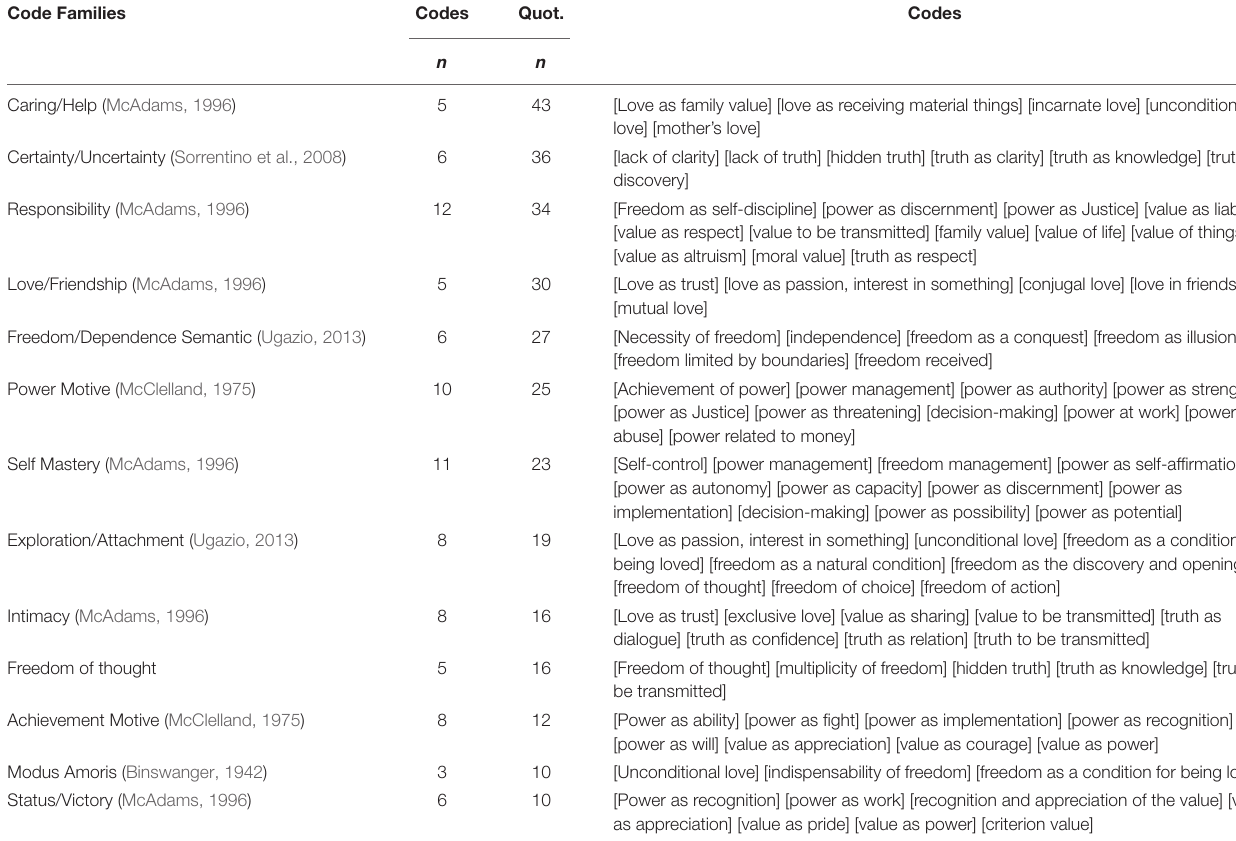
TABLE 4 | Code Families related to literature in the first Hermeneutic Unit (HU1). Code Families Codes Quot.